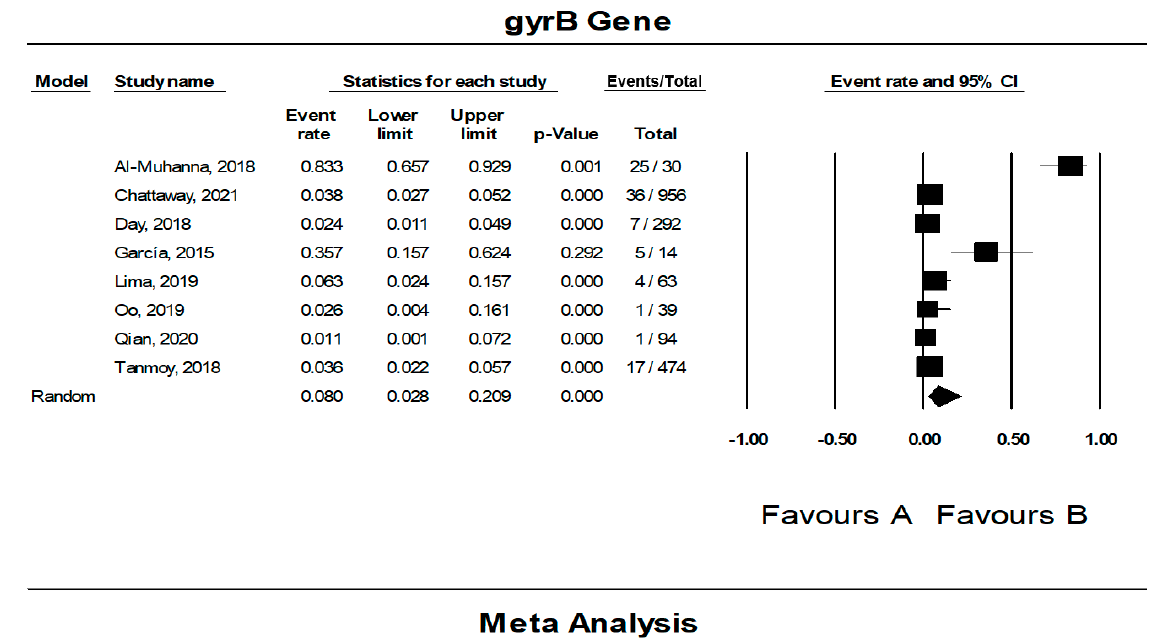
Figure 7. Forest plot showing the pooled prevalence of gyrB gene in resistant S. Typhi isolates estimated by a random effect model of meta-analysis. (8.0%, I 2 : 93.98, 95% CI: 2.8–20.9, p -value < 0.001) [21,24,26,31,36,41,42,49]. Table 4. Sub-group analysis of prevalence gyrB gene in S. Typhi according to countries and regions.